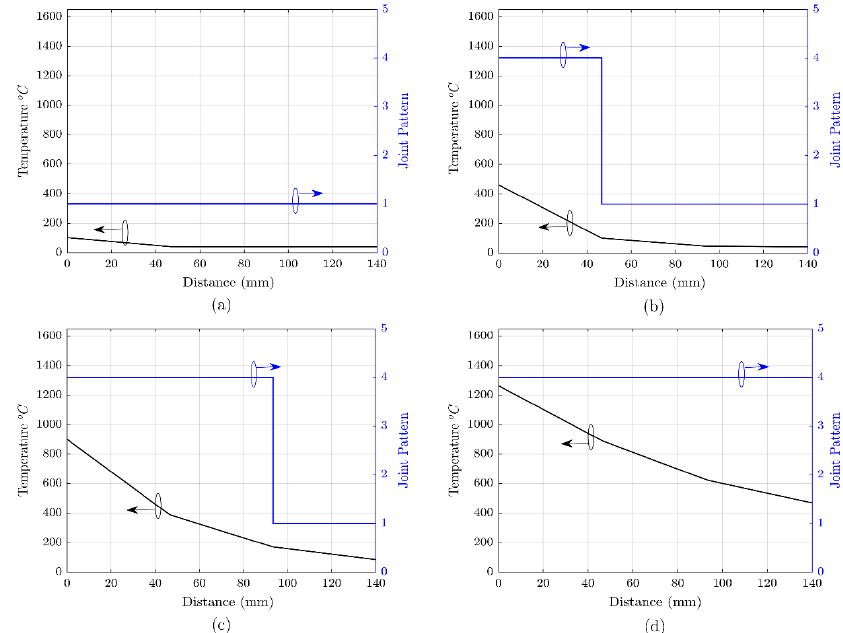
Figure 11. Temperature gradient and joint pattern through the thickness of the working lining (height = 2500 mm) for 0.1 mm bed and head joint thickness at ( a ) time = 50 s, ( b ) time = 675 s, ( c ) time = 1825 s, and ( d ) time = 7500 s.